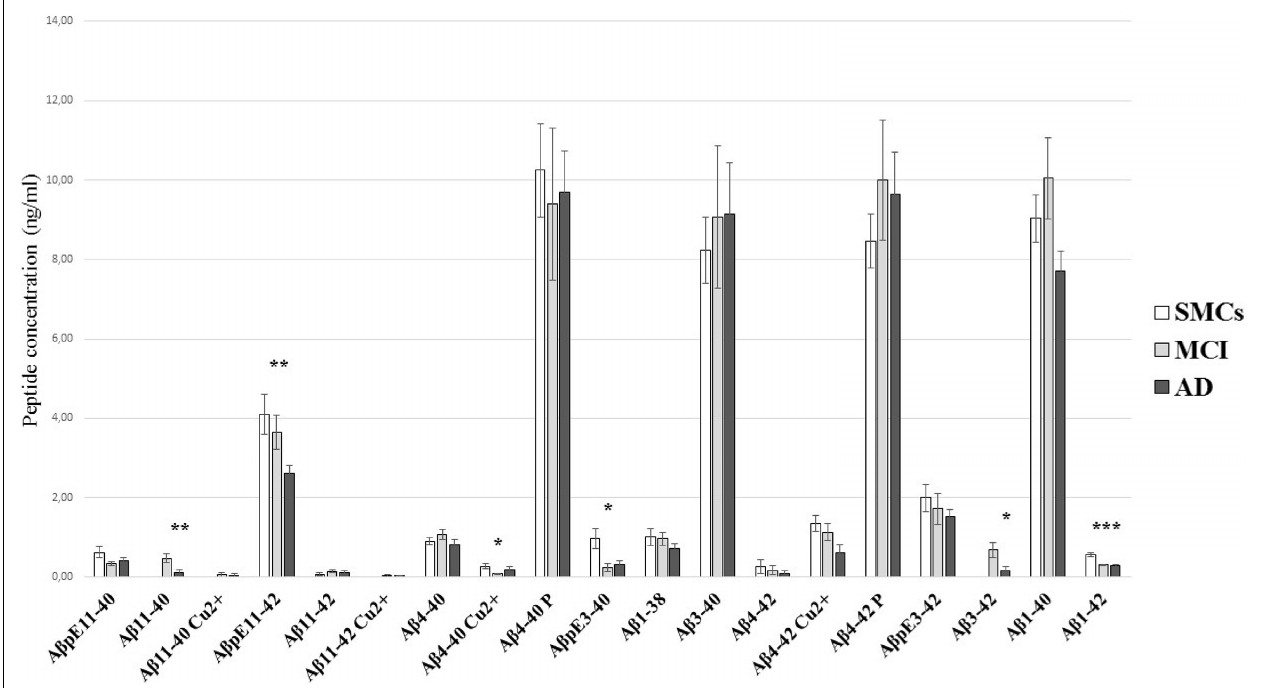
FIGURE 2 | A β peptide concentrations in hCSF. Comparison of the A β profile in CSF from SMCs, MCI, and AD patients. The quantitation of A β peptides by the newly developed ESI-LC-MS method showed substantial differences in A β profiles of AD and MCI CSF compared to SMCs. Bars show mean A β peptide concentrations (ng/ml) and standard error. Statistically significant differences are reported as * p < 0.05, ** p < 0.01, and *** p <